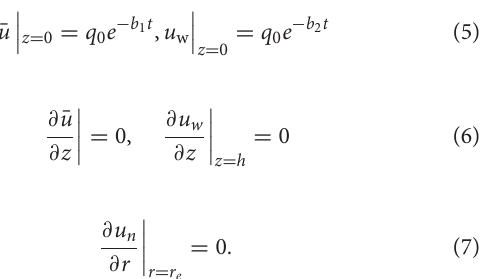
The top boundary in this model is considered to continuous drainage and the bottom boundary is considered to be undrained.